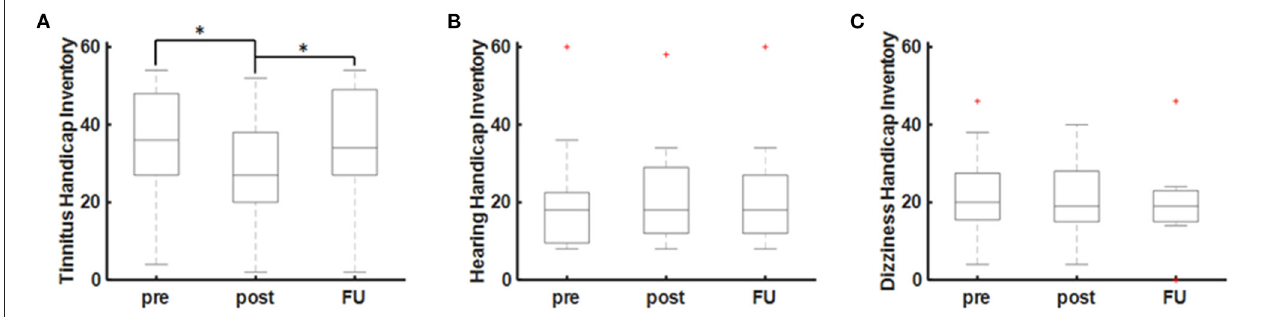
FIGURE 2 | rTMS effects on audiovestibular symptoms. (A) Tinnitus as measured by the Tinnitus Handicap Inventory (THI). (B) Hearing as measured by the Hearing Handicap Inventory (HHI) and (C) dizziness as measured by the Dizziness Handicap Inventory (DHI). Statistical significance is marked by an asterisk (* p < 0.005; paired t